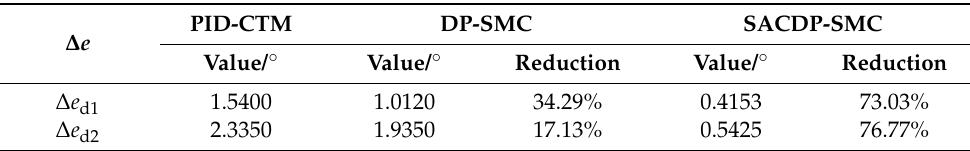
Table 5. The error variation of the three control